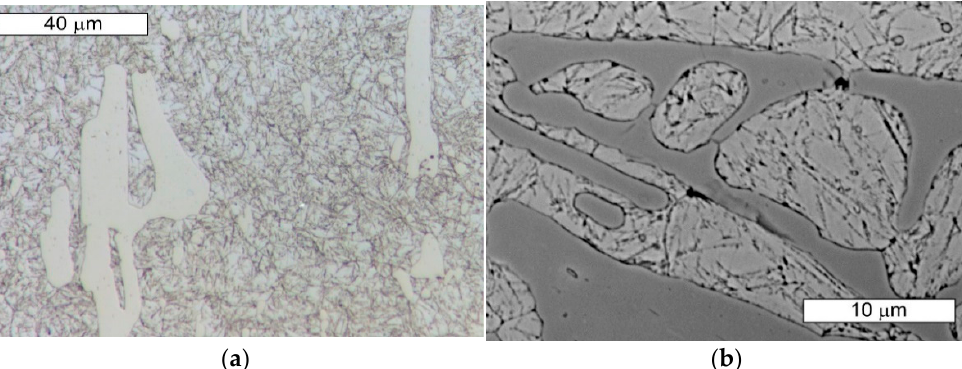
Figure 12. Magnified fragment of the area from Figure 11. Visible large primary carbide precipitations in the tempered martensite matrix; etched state: ( a ) light microscopy; ( b ) SEM.